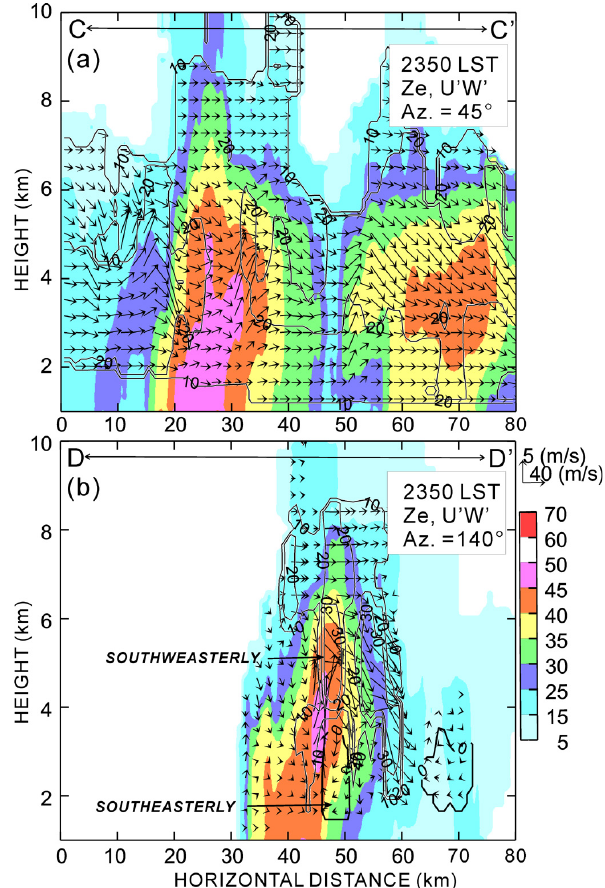
Fig. 15. Same as Fig. 13, but for 23:50LST, 9 July